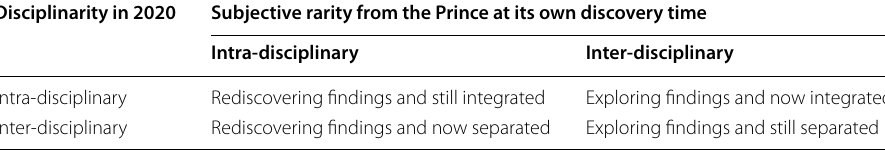
Table 1 Classification of findings of sleeping by its Prince